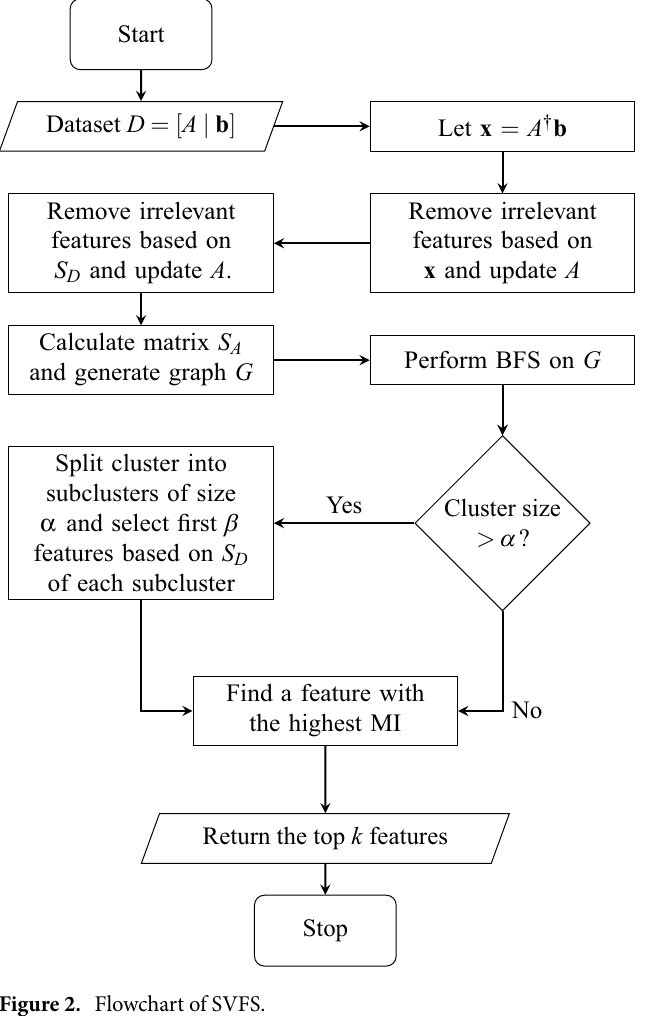
Figure 2. Flowchart of